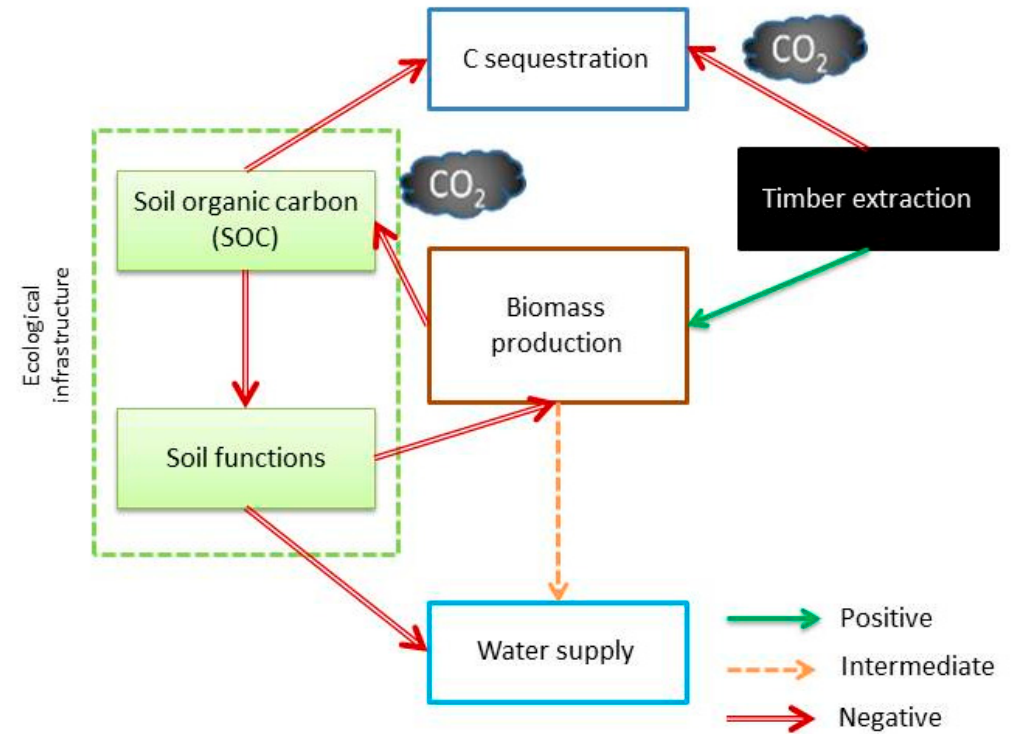
Figure 7. Relationship between ecosystem services, soil organic carbon, and soil functions in a timber extraction scenario. Note that the maximum water supply would be achieved with an intermediate tree density